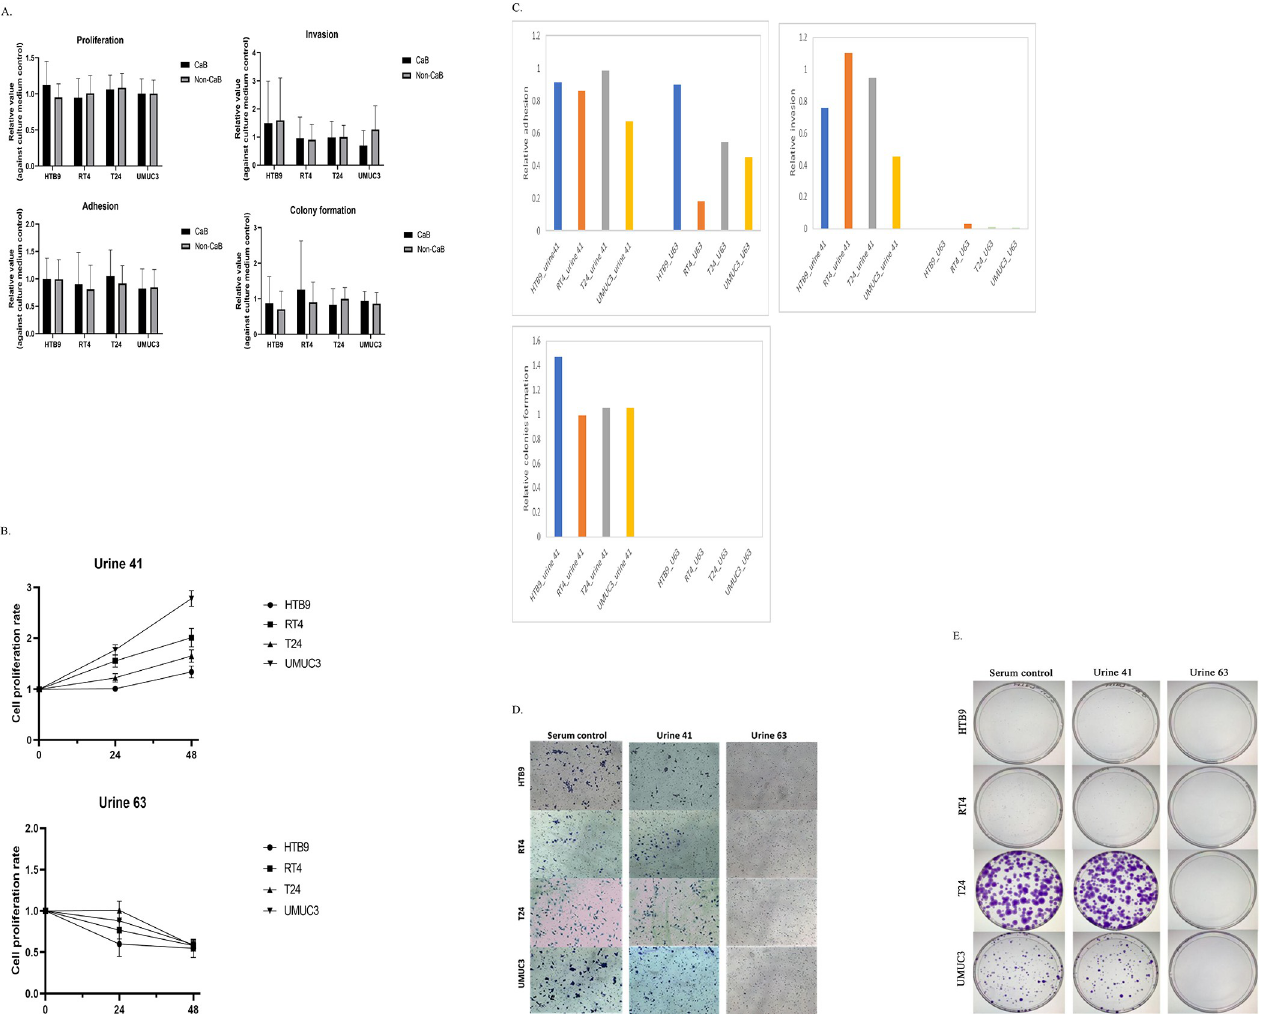
Fig 2. Tumorgenicity properties (A) After incubating in urine for 1 hour, 1x10(6) living cells were collected for proliferation, adhesion, invasion and colonies formation assay. CaB and non-CaB urines showed similar toxicity in all four cell lines. Data was presented as relative value against culture medium control. (B) CaB U41 and non-CaB U63 were showing significant result on all four cell lines. For proliferation assay, living cells were evaluated by MTT. U41 promoted cell proliferation and U63 suppressed or killed all cells for all four cell lines. (C) For adhesion assay, adhesion ability was evaluated by measuring the attached cells by MTT assays and OD reading was proportional to the number of adhered cells. U41 preserved the adhesion ability of HTB9, RT4 and T24, while U63 inhibited the cell adhesion of RT4 significantly. (D) To evaluate the invasion ability, cells passing through the matrigel were stained with Crystal Violet and total number of invasive cells were counted using the ImageJ software. (E) Colonies formation abilities were determined by seeding 1000 living cells onto a 100mm plate and incubated for 9 days. Colonies were then stained with crystal violet and colonies with more than 50 cells were counted. All data above was presented as relative value against culture medium control and all assays were done in